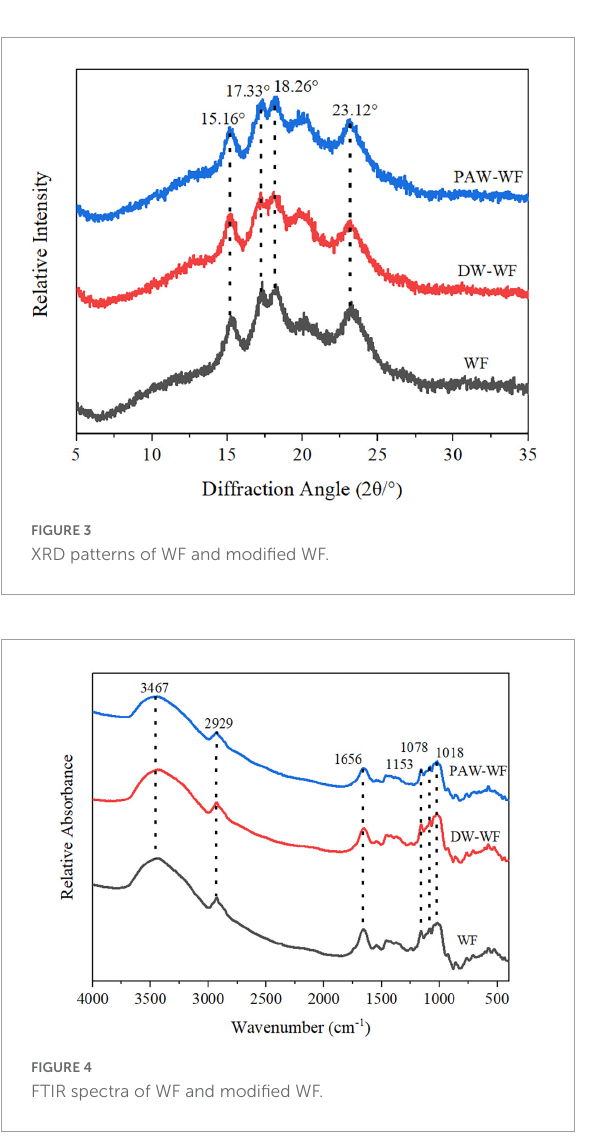
(SD) of all repeated measured data. ANOVA and Duncan’s multiple comparison tests ( p < 0.05) were performed using SPSS statistics 26.0 software (IBM, Chicago, IL, United States) to determine significant differences between means. Graphs were made using Origin 2018 (Origin-Lab Inc., Northampton, MA, United